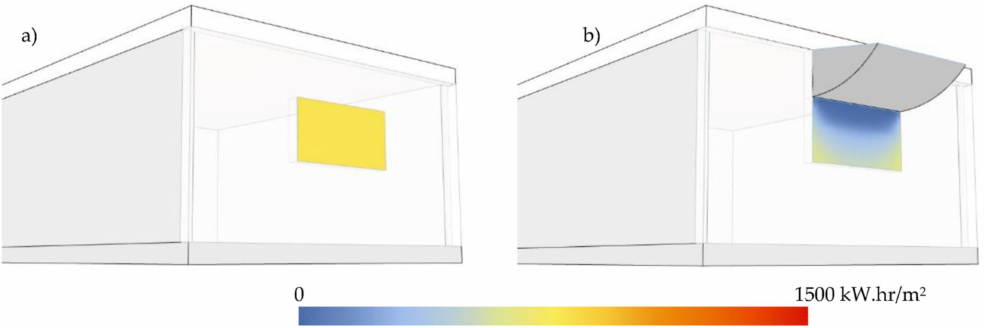
Figure 16. Yearly direct sunlight exposure for the window: ( a ) Reference room and ( b ) ADS-installed room.